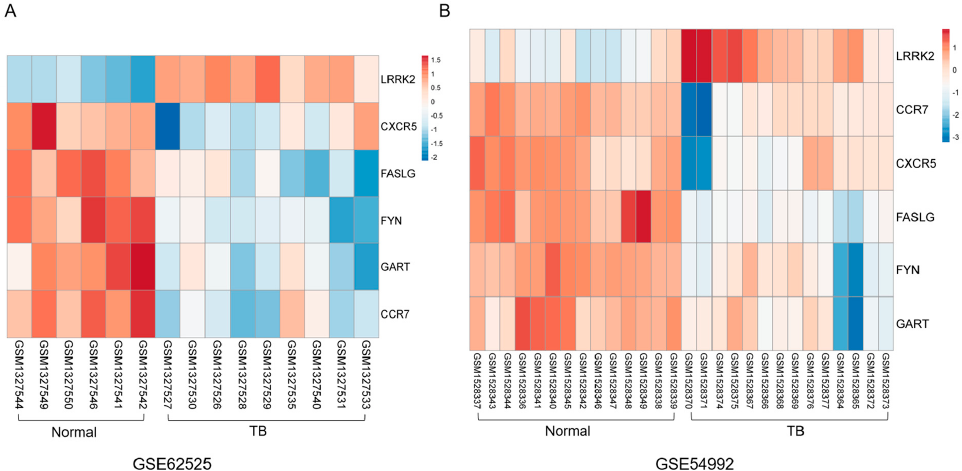
Figure 5. Heat map of top 6 hub genes’ expression in both ( A ) GSE62525 and ( B ) GSE54992. Blue represents downregulation, and red represents upregulation.